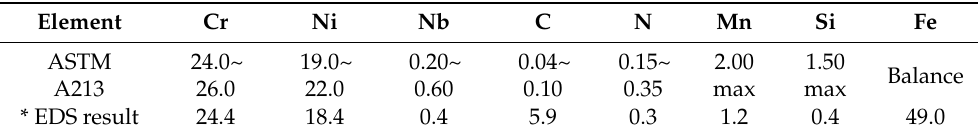
Table 1. Chemical composition of the HR3C steel (wt. %).